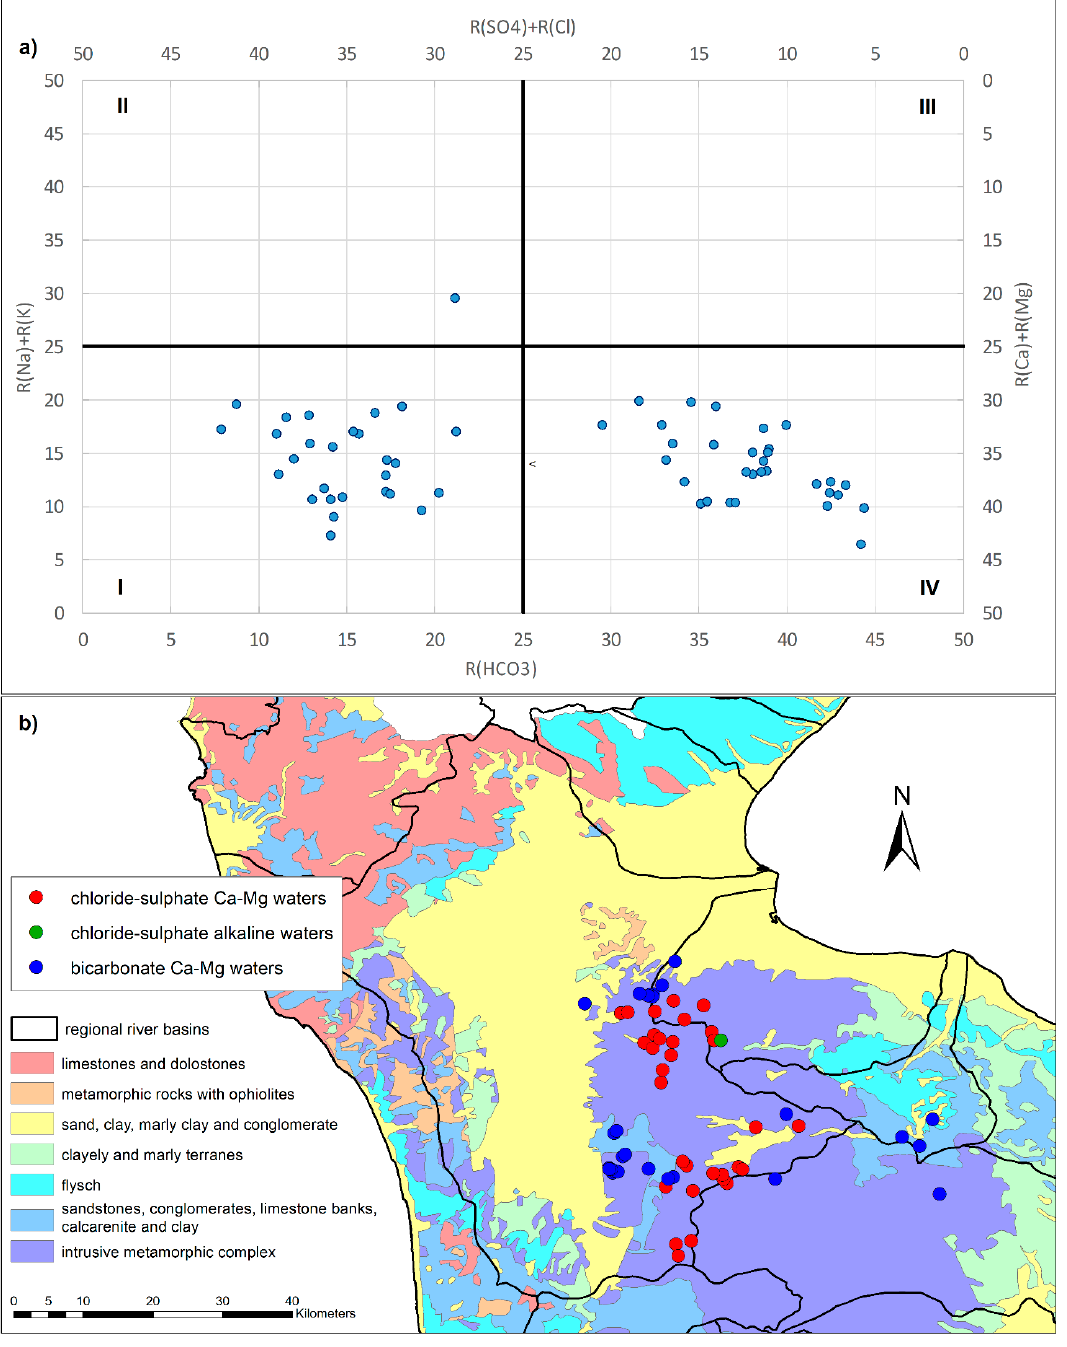
Figure 4. Langelier–Ludwig (LL) diagram ( a ) and classification of the spring waters (LL quadrants) according to geology ( b